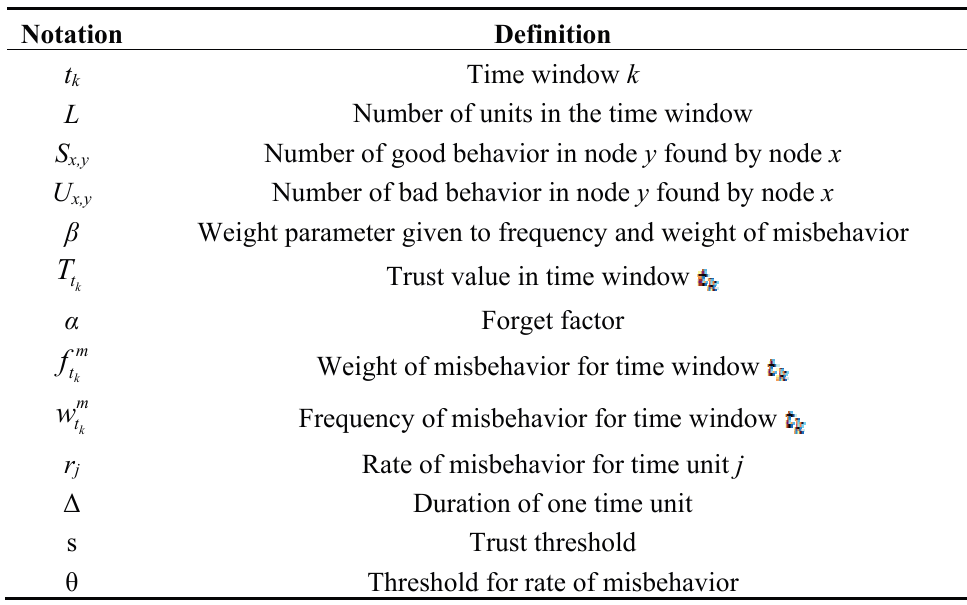
Table A1. Definitions of notations.